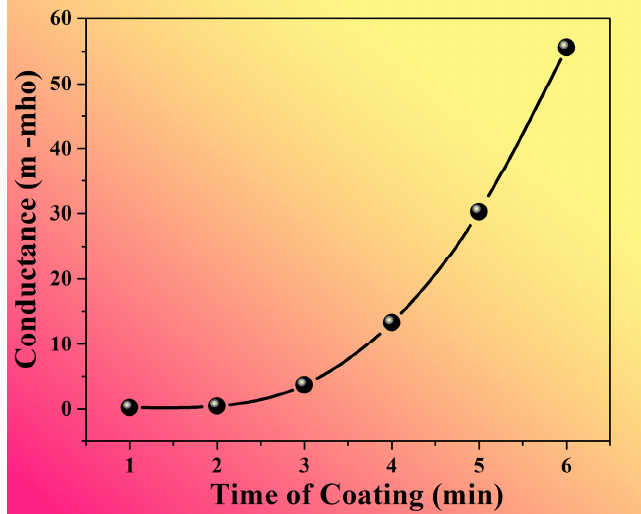
Figure 7. Relationship between coating time and conductance.